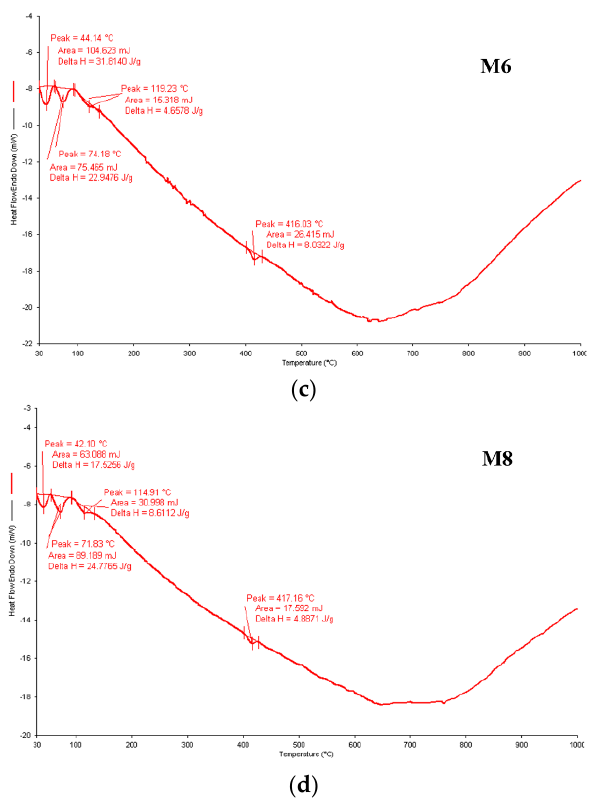
Figure 9. Di ff erential scanning calorimetry (DSC) curves of SAR specimens at 28 days. ( a ) M2 paste, ( b ) M4 paste, ( c ) M6 paste, ( d ) M8